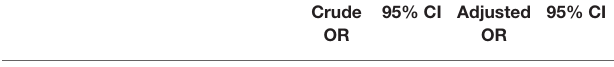
TABLE 4 | Logistic regression analysis to explore expecting variables for workers’ mental health.